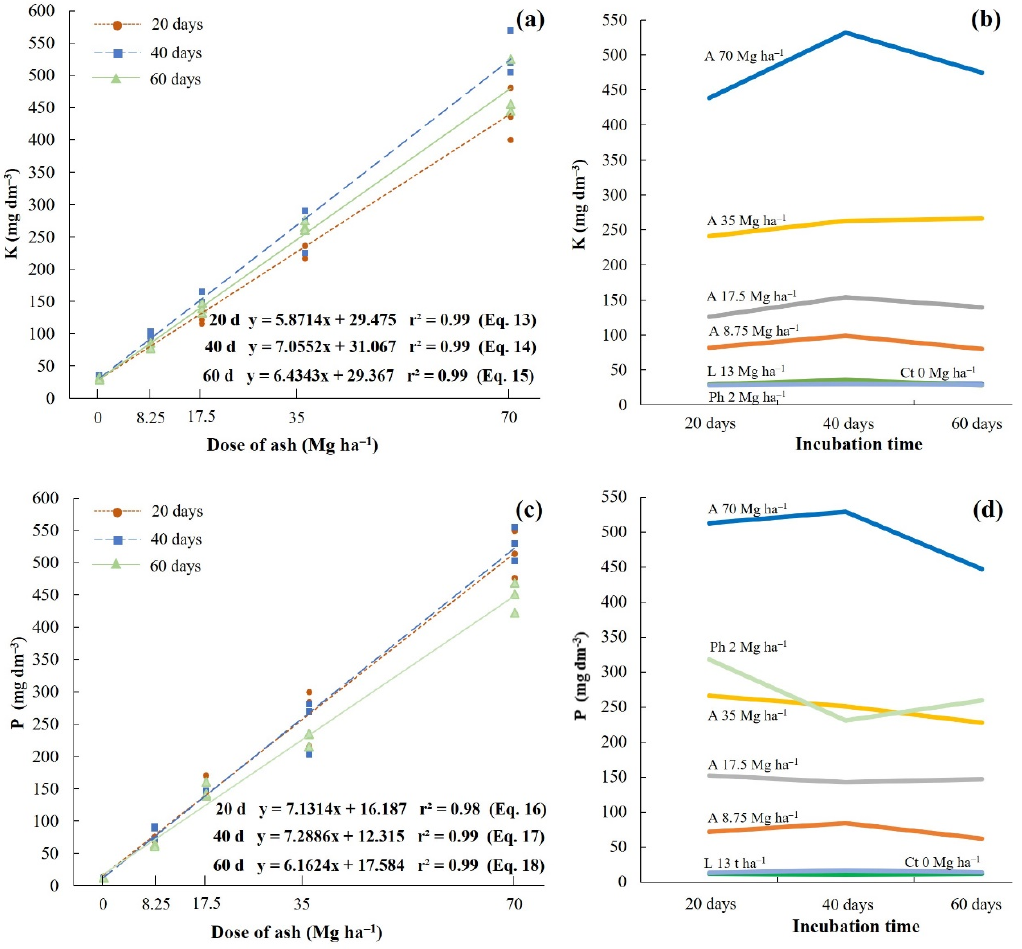
Figure 4. Chemical attributes of the Yellow Latosol after the three incubation times: extractable K ( a ) and P ( c ) as a function of the ash doses; evolution of K ( b ) and P ( d ) levels as a function of the three incubation times of the control soil (Ct) and soil treated with different ash doses (A), lime (L), and phosphate fertilizer (P).